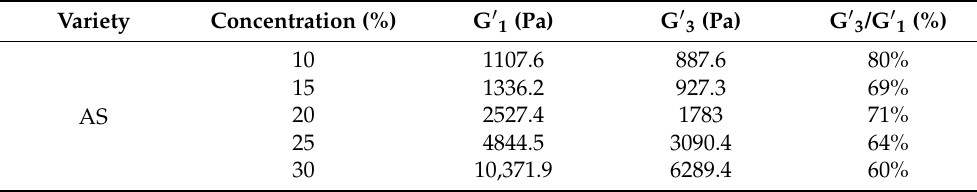
Figure 6. Three-interval thixotropy test of arrowroot starch samples with concentrations ranging from 10% to 30% ( w/v ). Table 1. Parameters during the three-interval thixotropy tests (3ITT) for AS concentrations ranging from 10 to 30% ( w/v